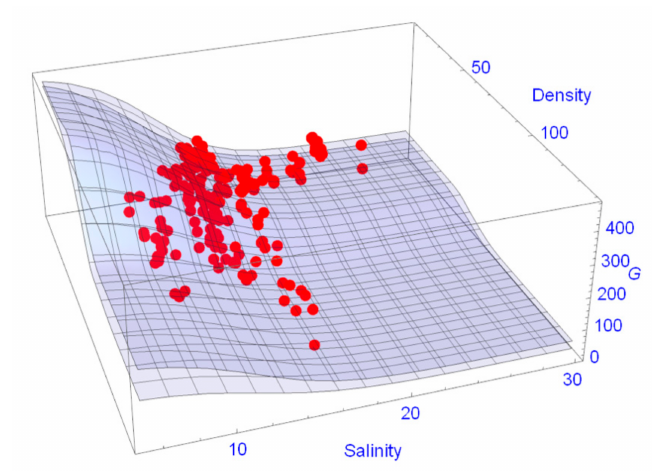
Figure 7. 95% confidence surfaces together with the G values of the validation data set.